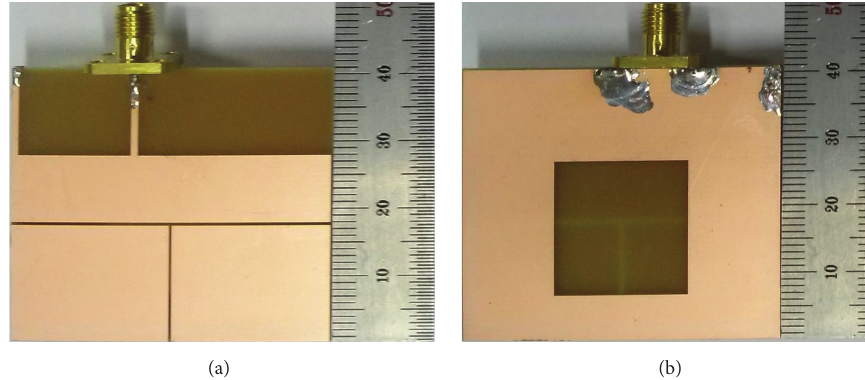
Figure 10: Manufactured prototype antenna: (a) top view and (b) bottom view.